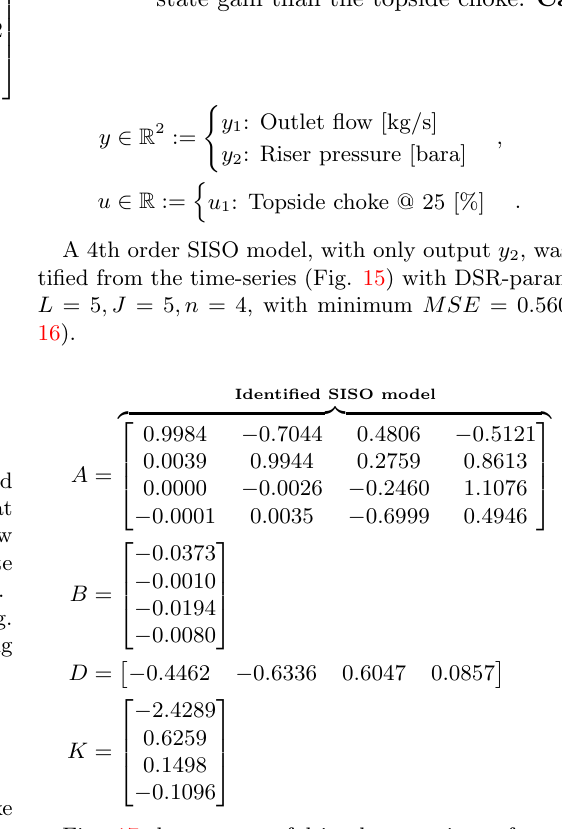
Figure 10: Open-loop simulations in K-Spice. Subsea choke looks to have a much higher steady state gain than the topside choke. Case B